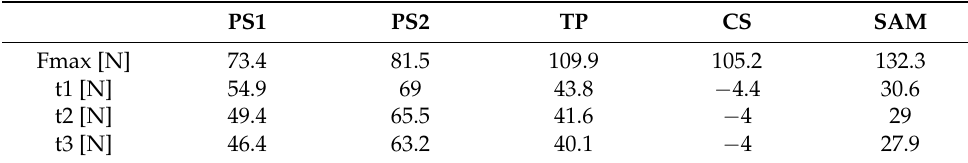
Table 3. Mean values of the acting tensile forces of the five measurements with each of the four pelvic slings (PS1 = pneumatic sling VBM ® with pressure of 100 mmHg, PS2 = pneumatic sling VBM ® with pressure of 200 mmHg; TP = T-POD ® ; CS = cloth sling; SAM = SAM Sling ® ) at the defined time points (Fmax = maximum force; t1 = 45 sec after application; t2 = 80 sec after application; t3 = 120 s after application; source: Haussmann [22],